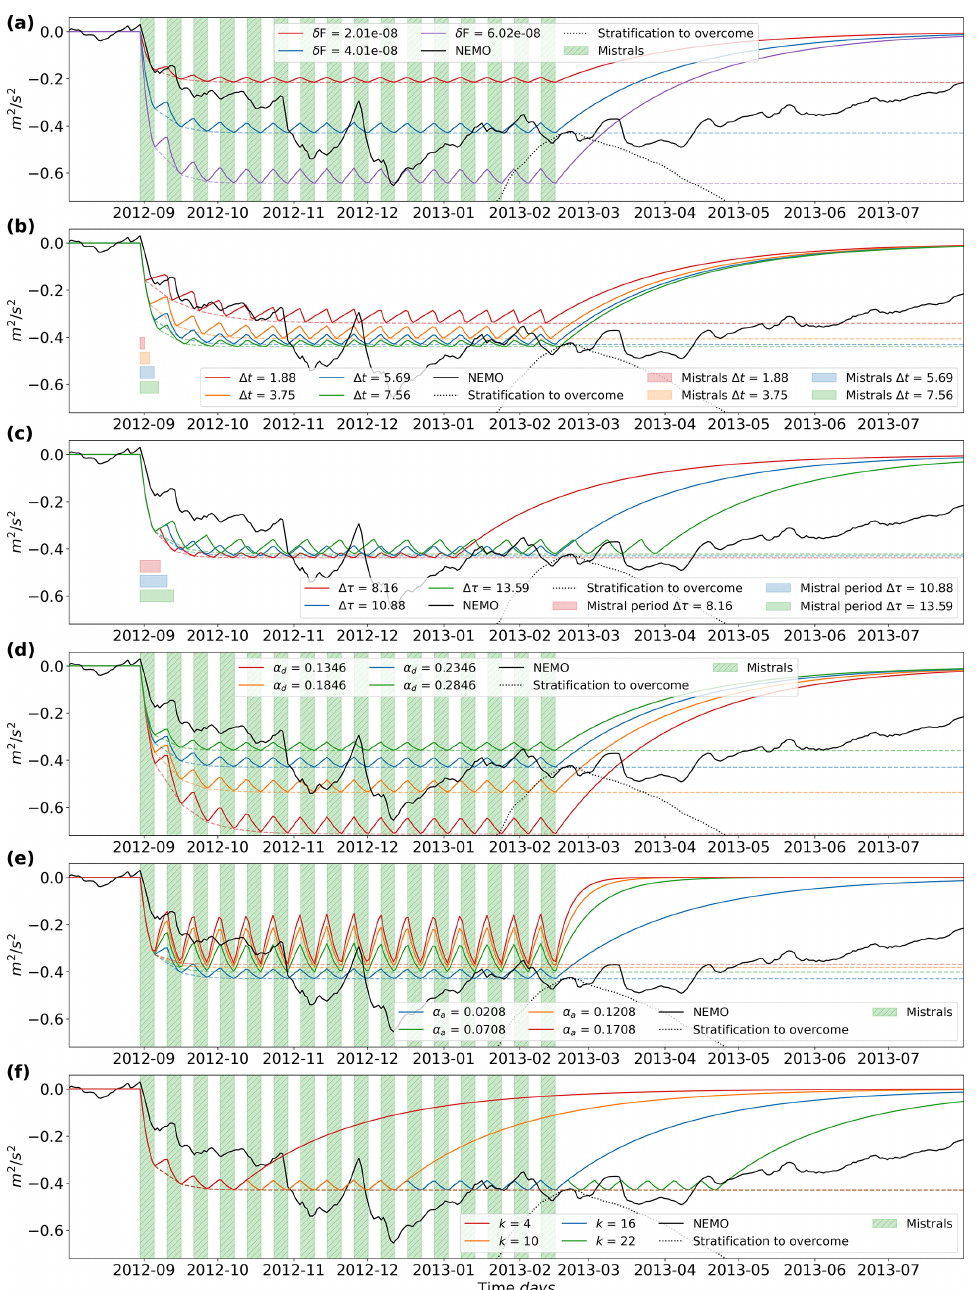
Figure 12. Equation (18) plotted with one variable varying in each plot with the other variables held constant at the mean value. Panel (a) varies the strength of the mistral, δF , (b) varies the duration, (cid:49)t , and (c) varies the period between events, (cid:49)τ . Panel (d) varies the restoration coefficient during the destratification phase, α d , and (e) varies the restoration coefficient for the restratification phase. Panel (f) varies the number of